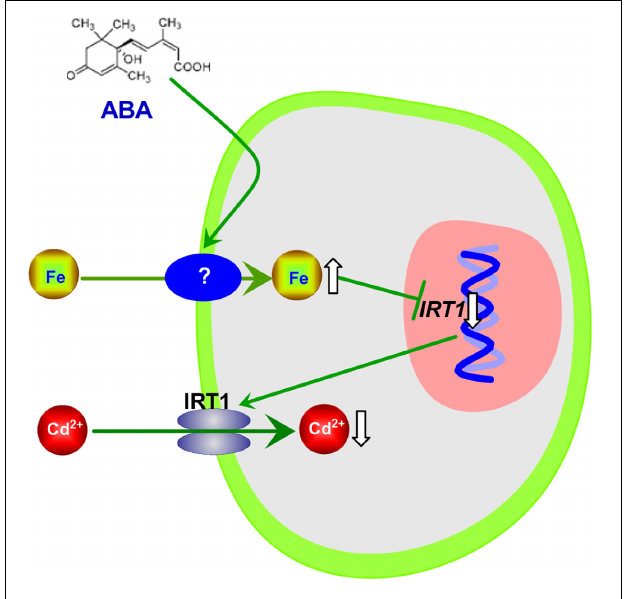
FIGURE 8 | Schematic model of ABA-mediated decrease in Cd accumulation in Arabidopsis